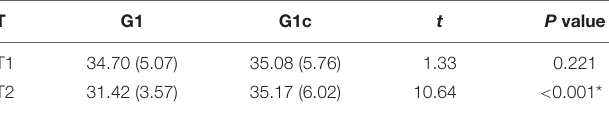
TABLE 5 | Comparison of T1 and T2 CARS scores between G1 and G1c.